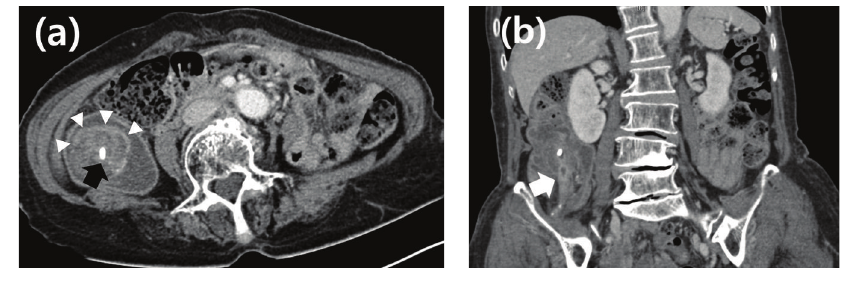
Figure 1: Abdominal computed tomography. Transverse (a) and coronal (b) views revealed invagination of the caecum and the appendix into the lumen of the ascending colon, as well as mural thickening and enhancement of the dilated appendix (9.7 mm) with a few appendicoliths.